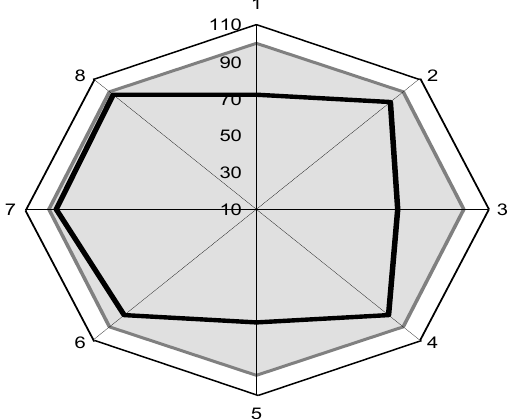
Fig.1. Functional characteristics of ski-racers at TAM level (% from reference